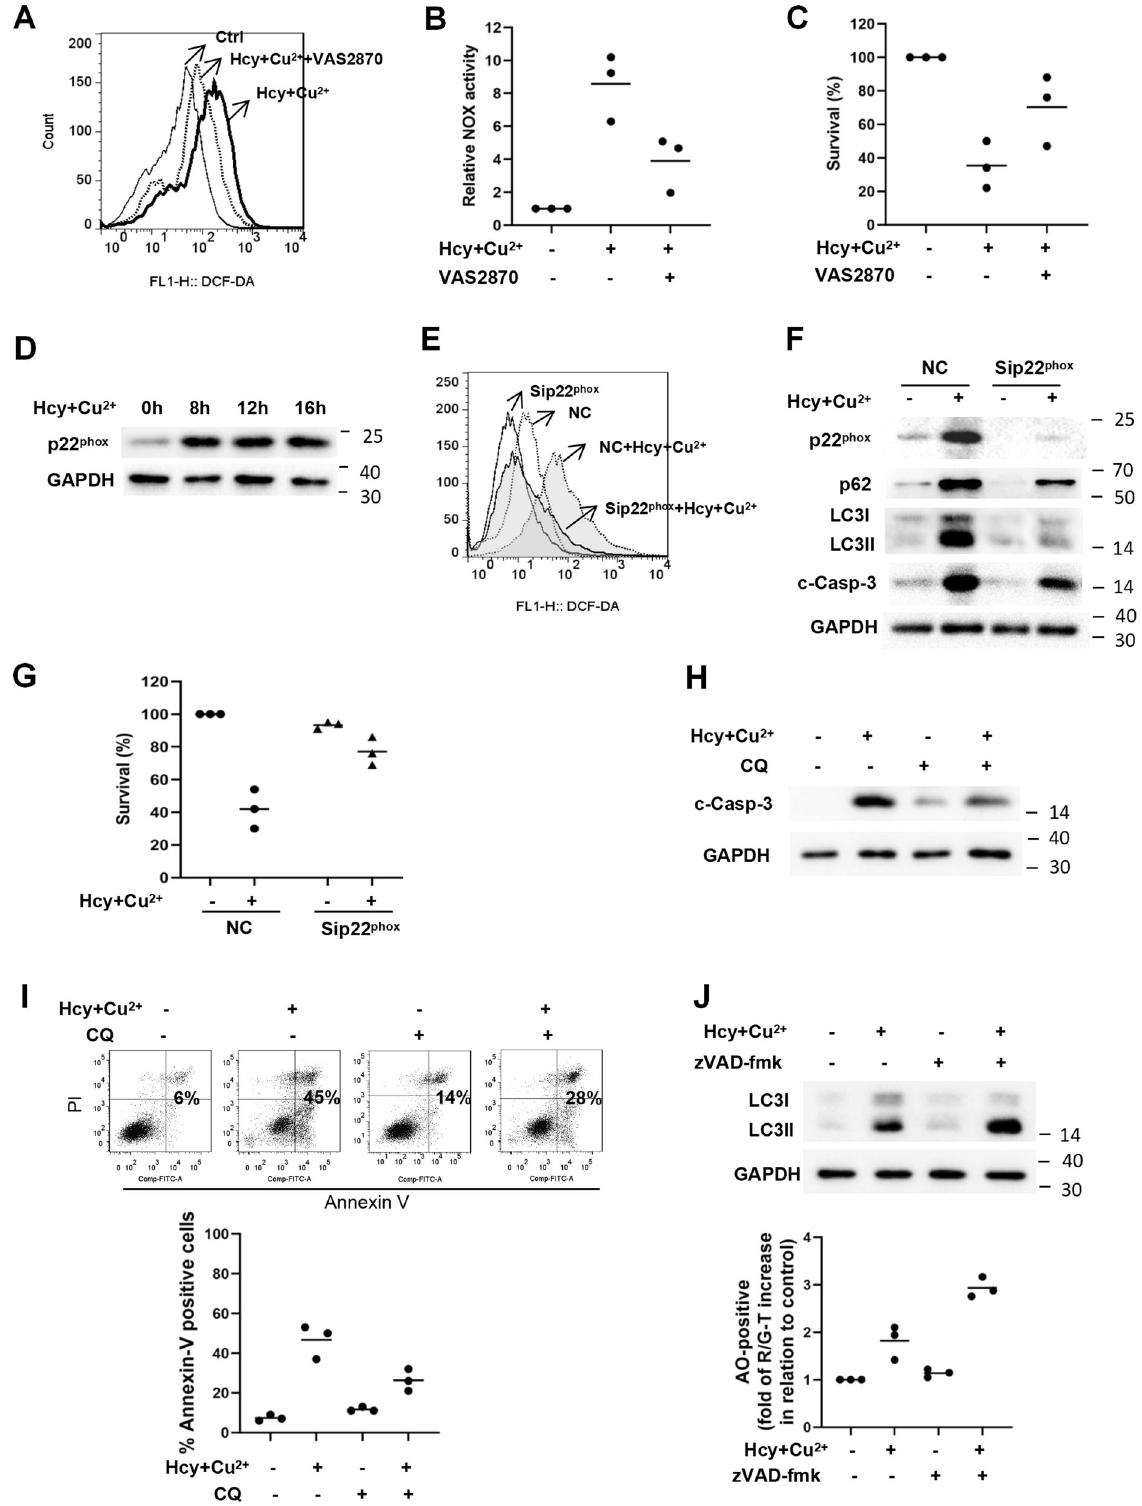
Although autophagy and apoptosis are markedly different processes, several pathways regulate both autophagic and apoptotic machinery, and may induce the crosstalk between them. The current knowledge on the relationship between apoptotic and autophagic death is controversial, especially,